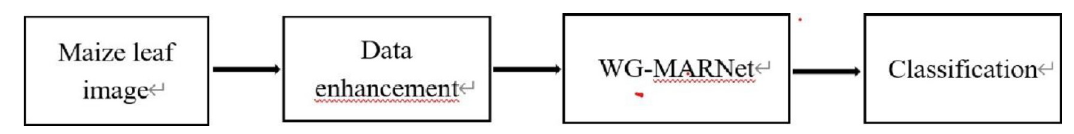
Fig 1. Flowchart of data enhancement and WG-MARNet